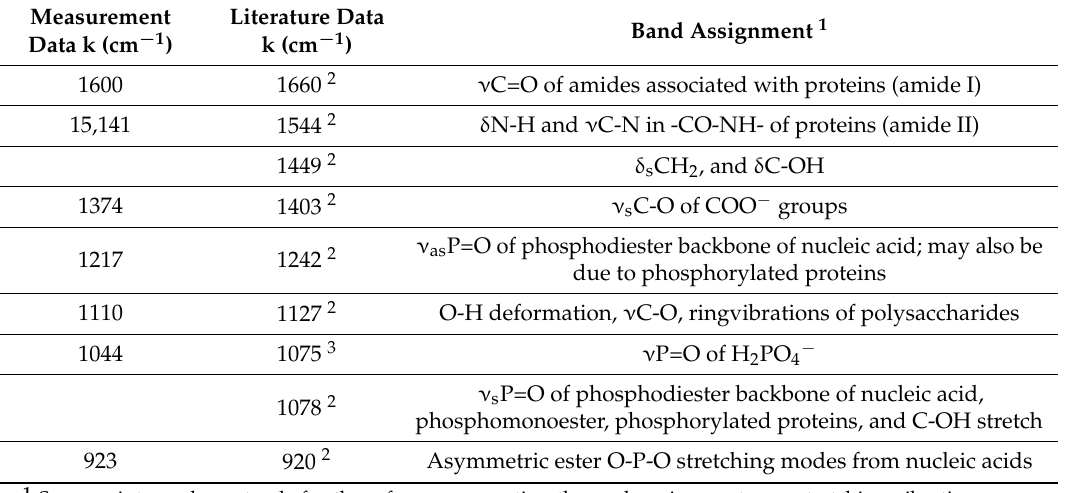
Table 2. Band assignment in the FTIR spectrum obtained from the pristine EPS based on the previous studies [30,35,36].